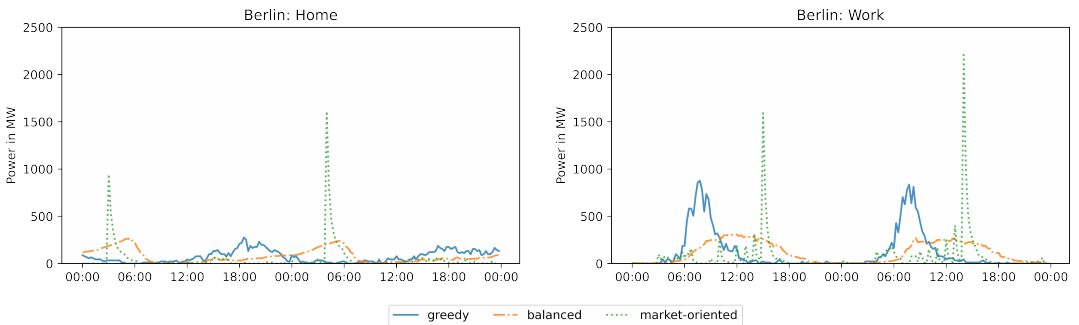
Figure 5. Load profile for each charging strategy in Berlin for 2 days in the private space.